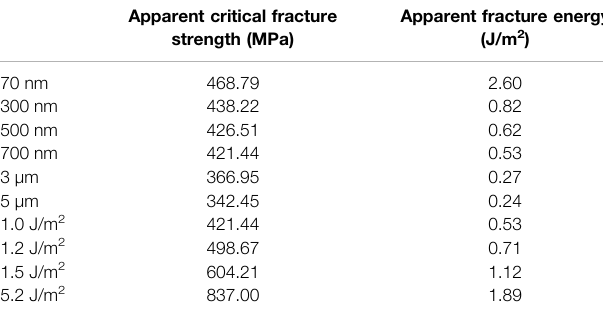
TABLE 2| Apparent critical fracture strength and apparentfracture energy of RVE